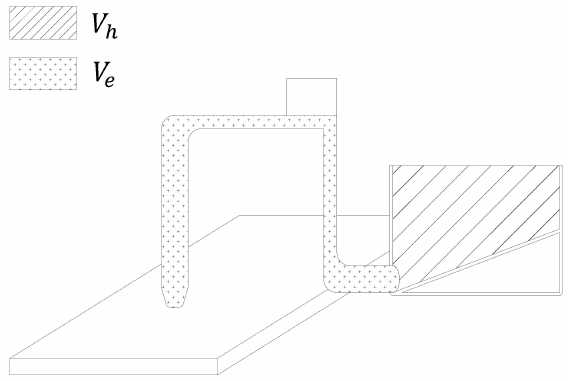
Figure 6. Volume of supplied fresh concrete into